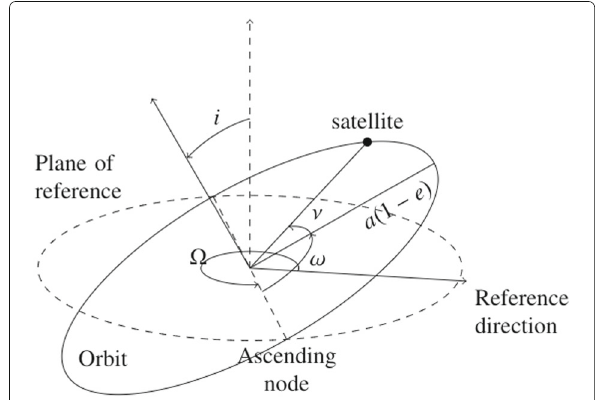
Fig. 6 Characterization of an ideal orbit and satellite position by Keplerian elements, where the reference direction is the vernal equinox direction, and the plane of reference is the Equatorial